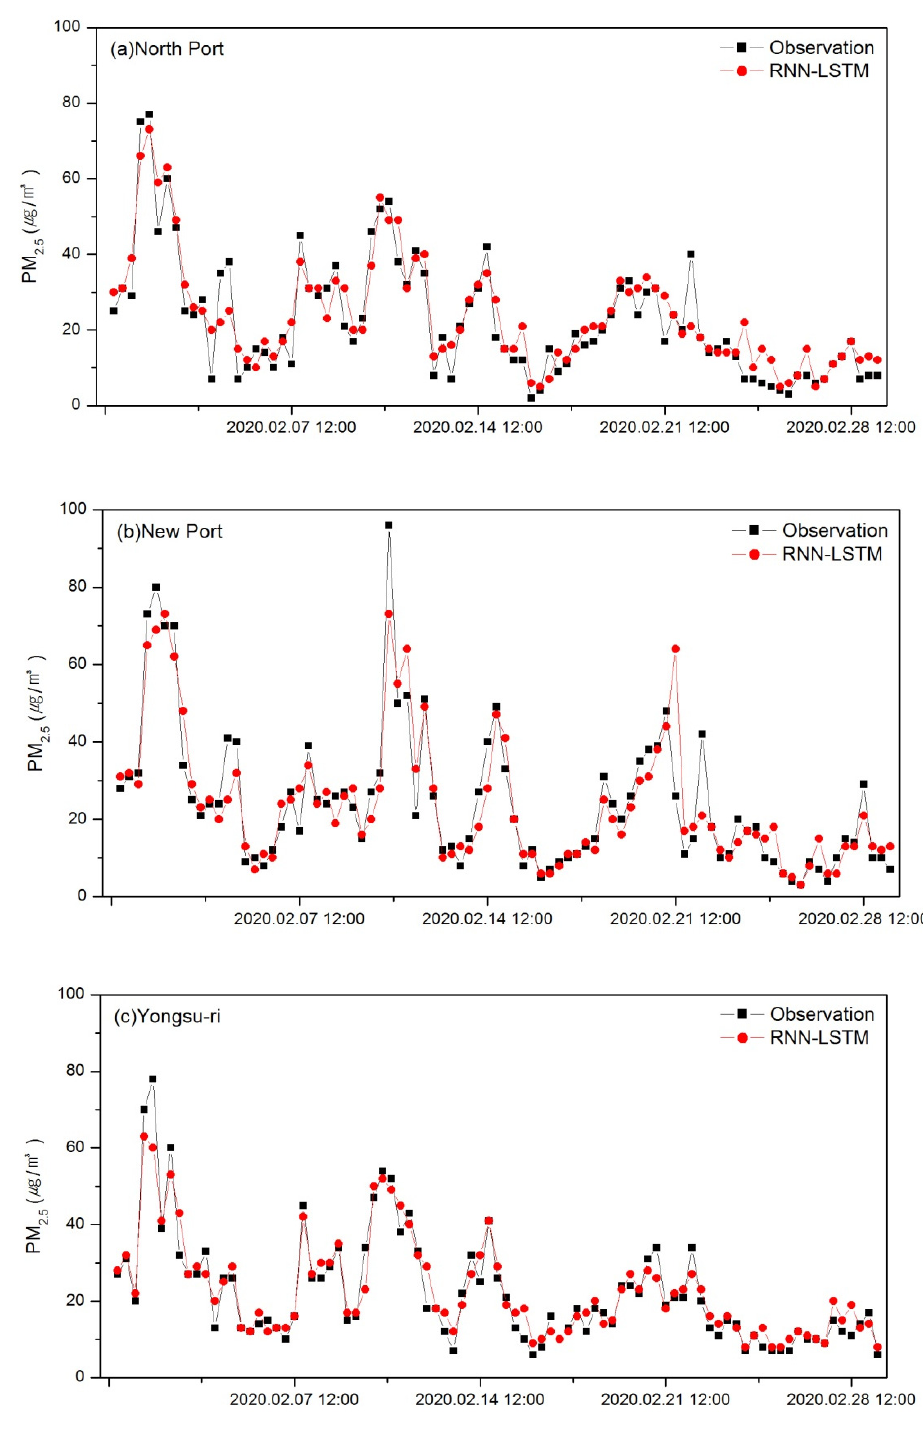
Table 8. Statistical comparison of RNN-LSTM-modeled and AQMS-observed PM 2.5 (North